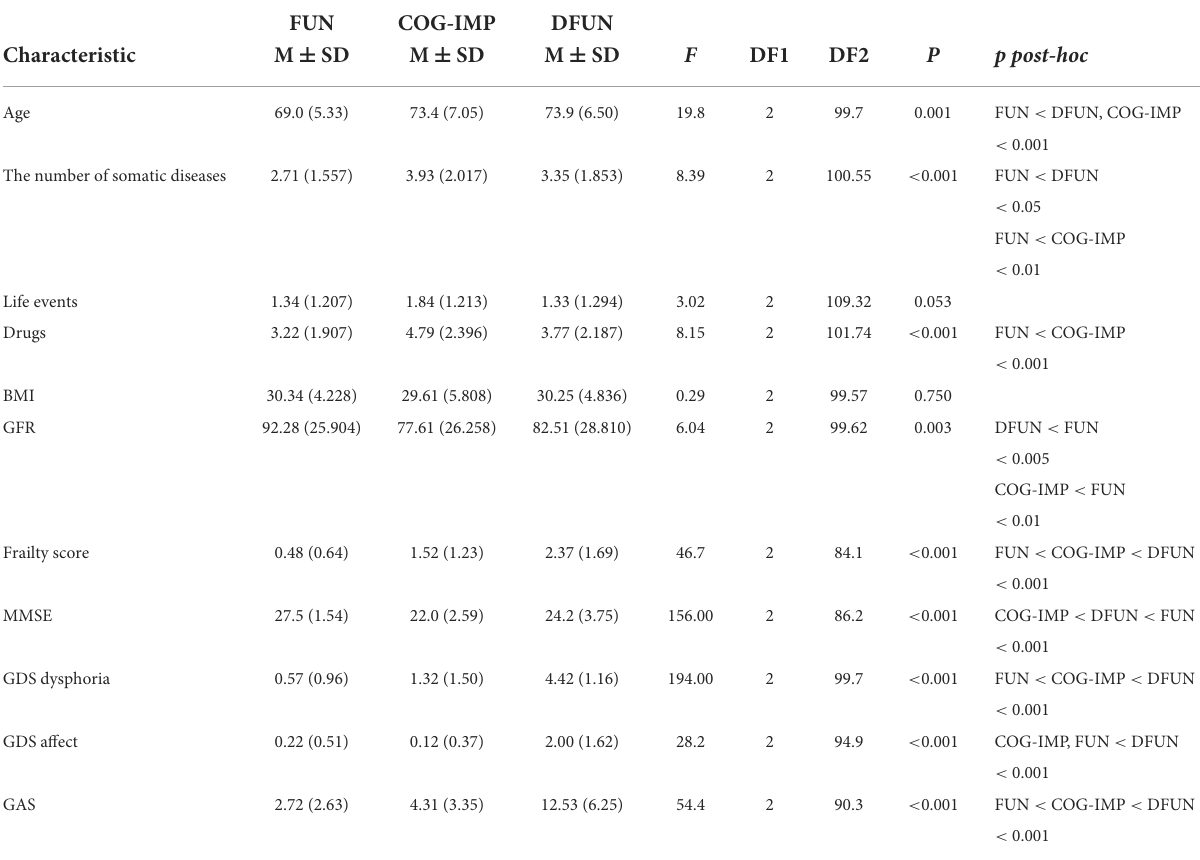
TABLE 4 Differences between patients in the clusters in the number of somatic diseases, important life events, the number of drugs prescribed, body mass index (BMI), glomerular filtration rate (GFR), and parameters used to identify clusters. FUN COG-IMP DFUN Characteristic M ±